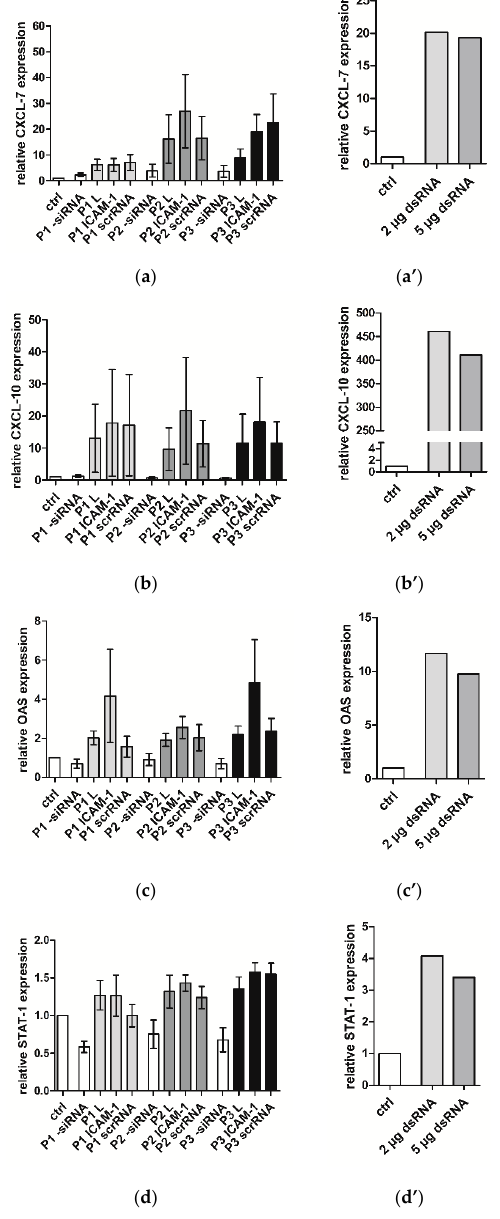
Figure 4 Figure 4. Immune response of hVECs analyzed by qRT-PCR after incubation with siICAM-1, scrRNA or Lipofectamine ® 2000 alone, PLGA 1–3 coatings and PLGA 1-3 alone. After 24 h incubation of coated slides with hVECs, RNA was isolated for qRT-PCR. The relative expression of ( a ) CXCL-7, ( b ) CXCL-10, ( c ) OAS, and ( d ) STAT-1 was compared to untreated cells. Another assay was the transfection of hVECs with dsRNA (2 and 5 µ g): ( a’ ) relative expression of CXCL-7, ( b’ ) relative expression of CXCL-10, ( c’ ) relative expression of OAS, and ( d’ ) relative expression of STAT-1. The expression of untreated cells was set to one. Each bar represents the mean ± standard error (SEM) of n = 4. The dsRNA was tested only once, n = 1. p =